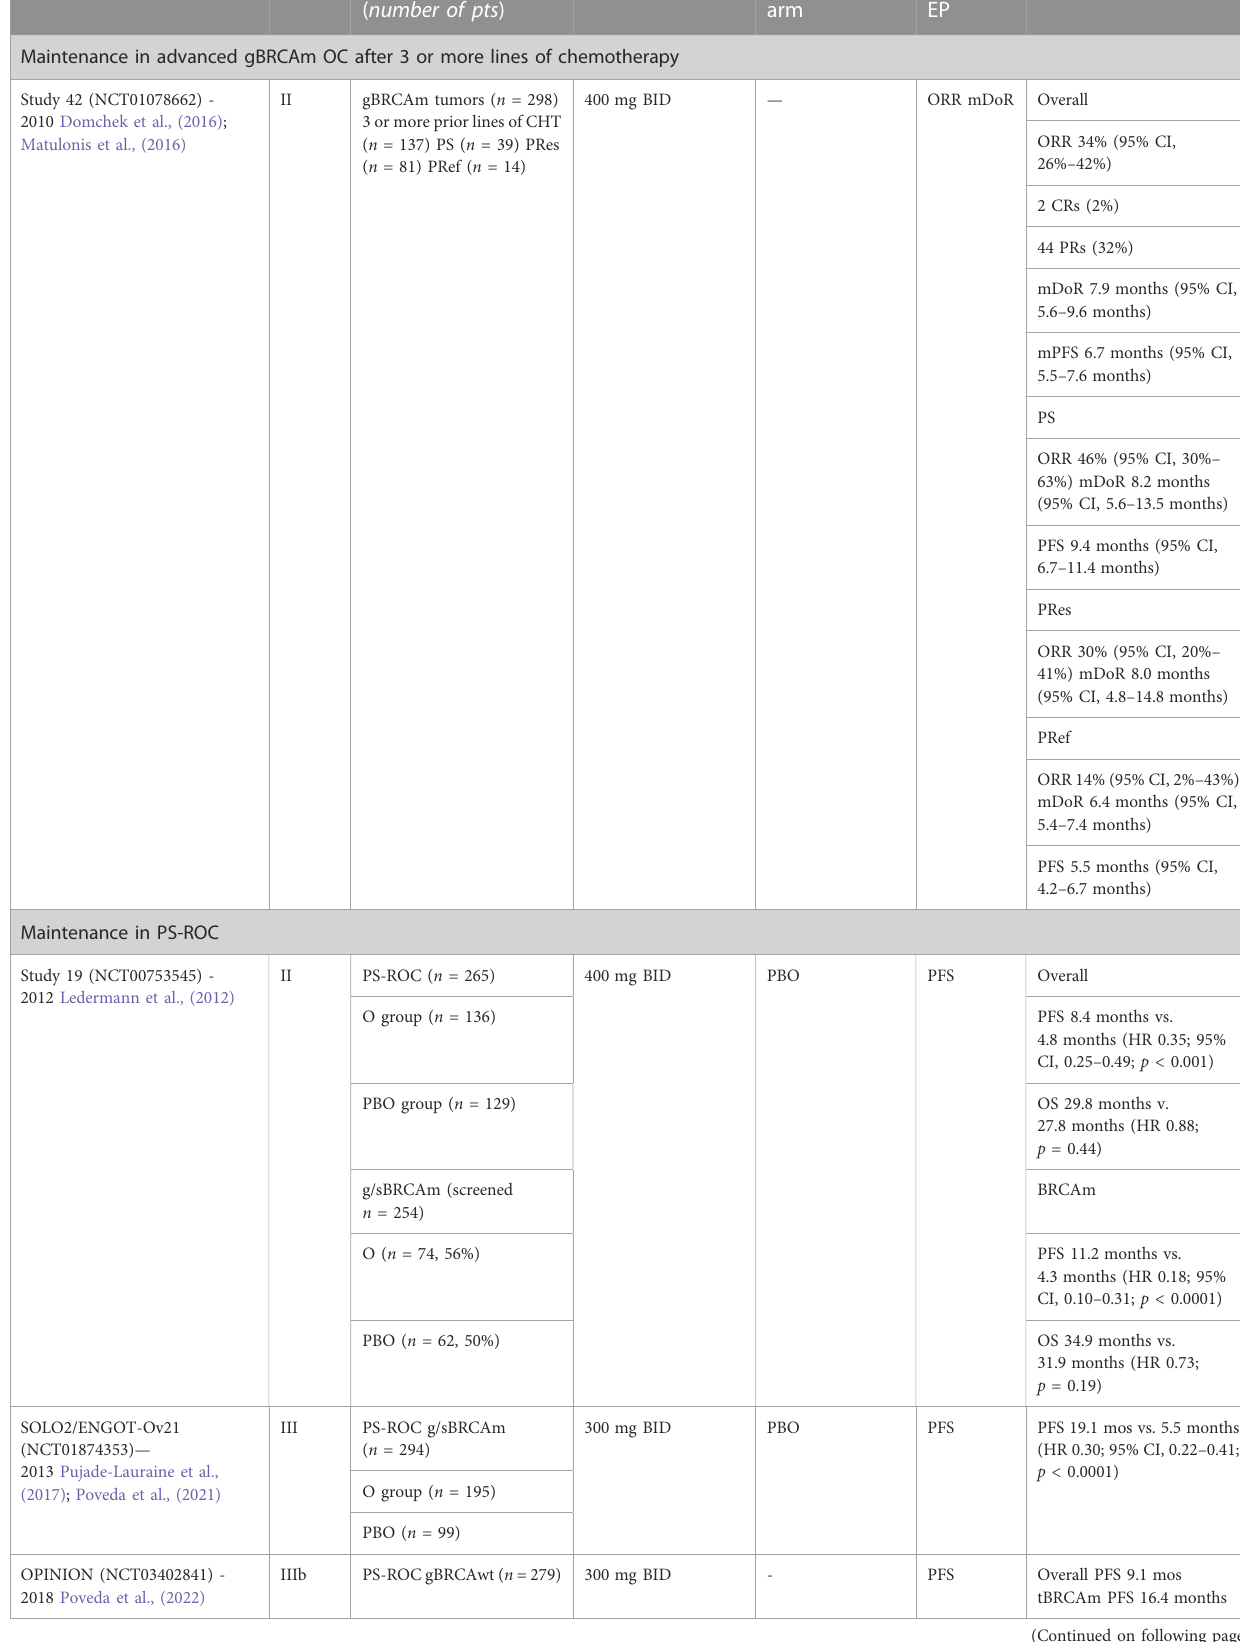
Olaparib dosage Comparative Primary Results ( number of pts ) arm EP